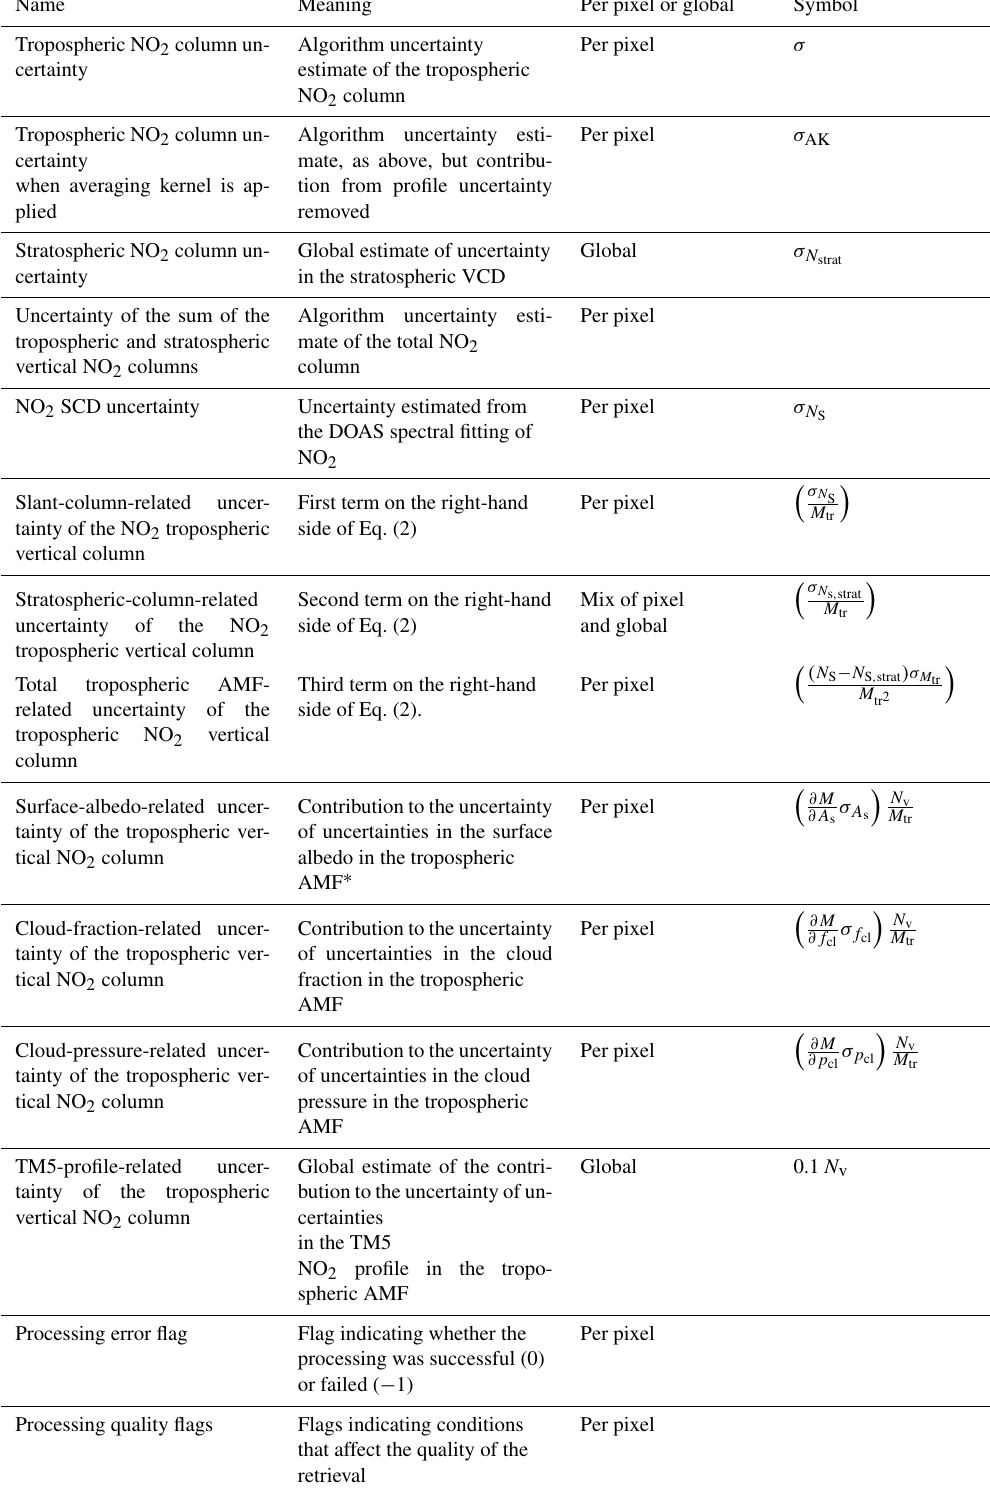
Table 5. Overview of the main uncertainty estimates and quality flags included in the QA4ECV NO 2 ECV precursor product. The third column indicates whether the estimate is unique for that pixel, derived from a global estimate, or is a blend of individual and global